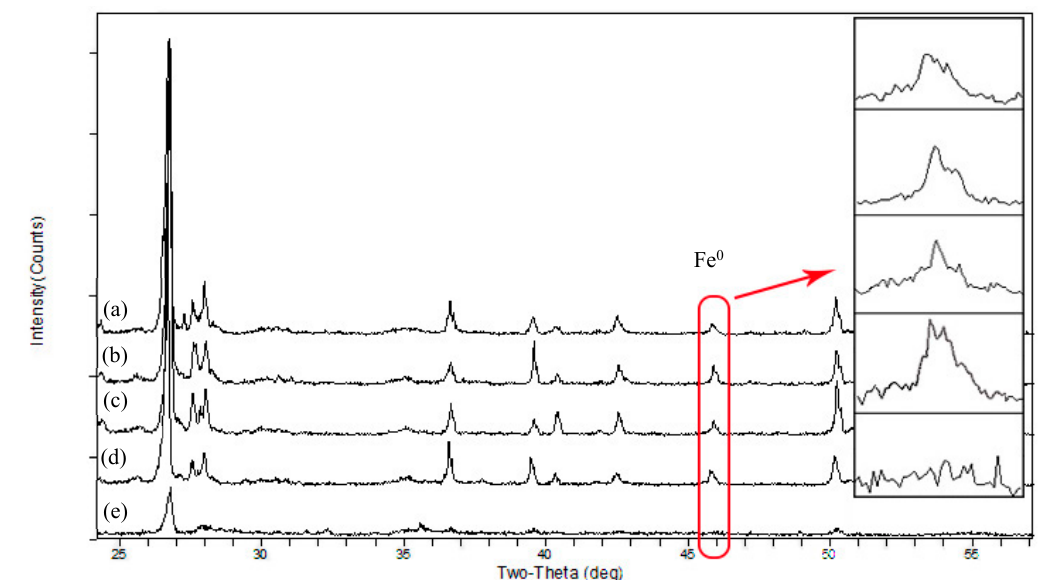
Figure 2. XRD characterization of BFe 0 NPs with different bentonite contents: ( a ) 1%; ( b ) 2%; ( c ) 3%; ( d ) 4%; and ( e ) 5%.